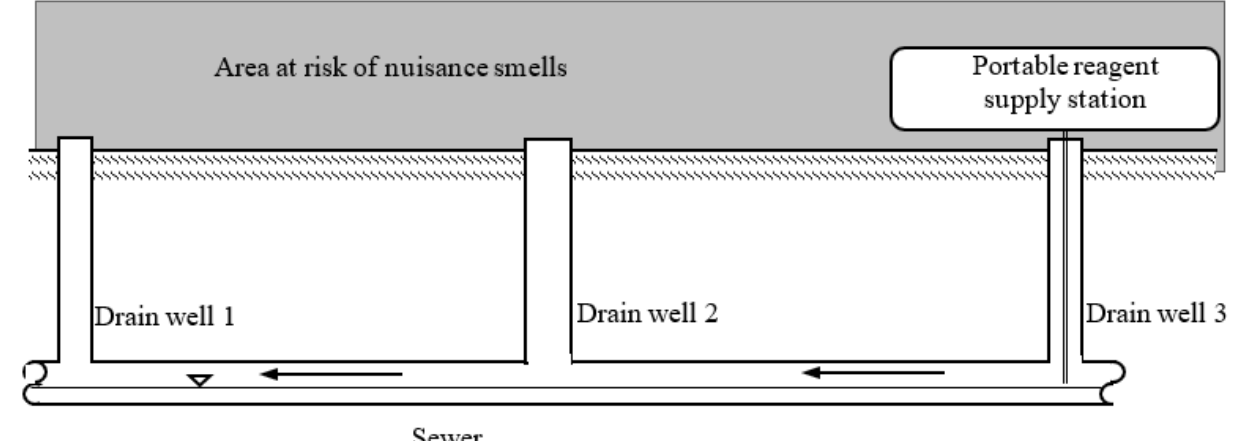
Figure 9. Diagram of the manual reagent injection system for sewage networks, with portable reagent supply station.